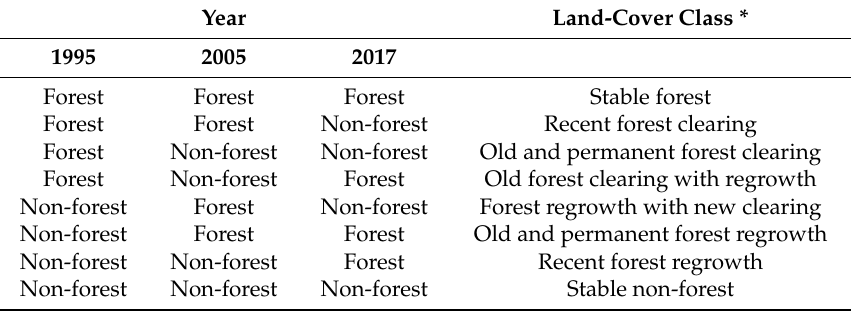
Table 3. Forest Cover Change Trajectories between 1995 and